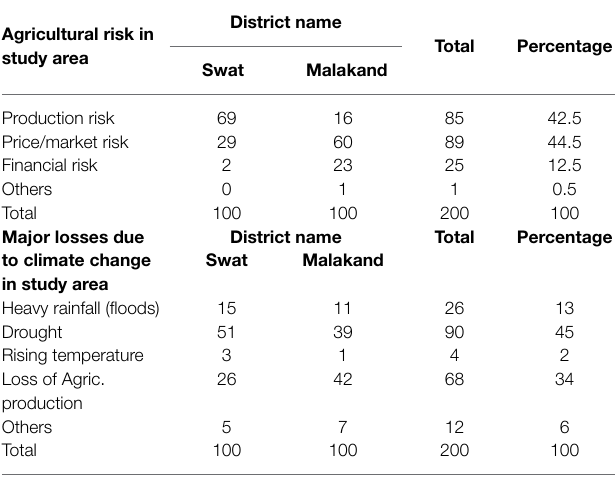
TABLE 3 | Information of the farmers regarding Agricultural risk and major losses due to climate change. Agricultural risk in study